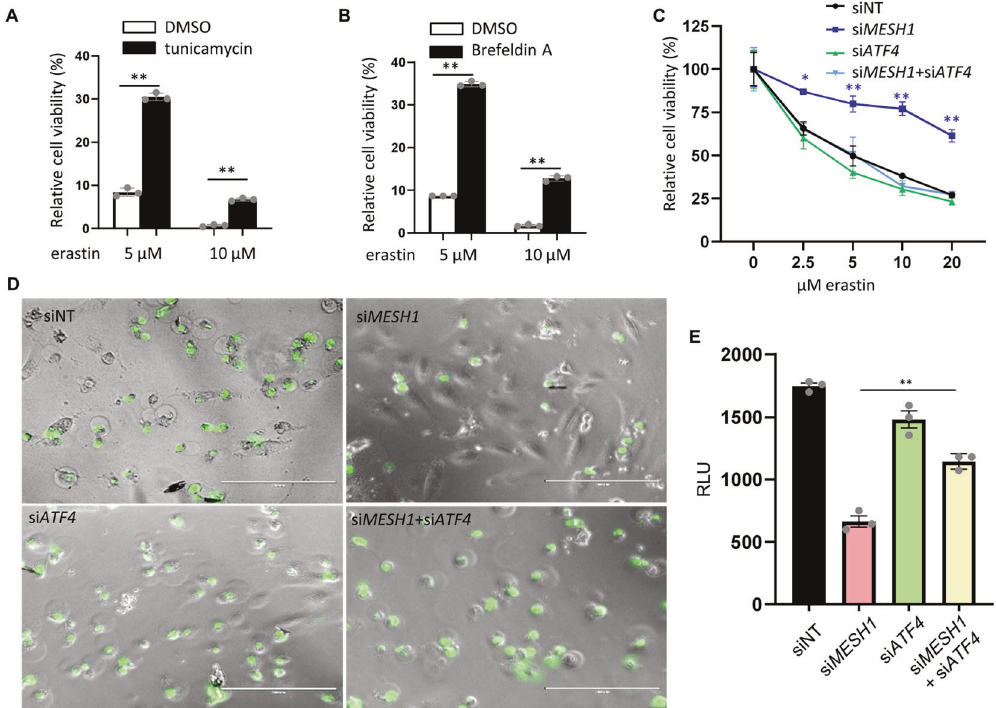
Fig. 4 ISR induced by MESH1 knockdown attenuates ferroptosis. A , B Tunicamycin and brefeldin A treatment prevents erastin-induced cell death. RCC4 cells were treated with erastin and in combination with tunicamycin (6 µg/ml) ( A ) or brefeldin (2 µg/ml) ( B ). The relative cell viability was determined by CellTiter Glo assay. C , D ATF4 -knockdown abolished the ferroptosis survival phenotype of MESH1 -knockdown in RCC4 cells as determined by CellTiter Glo assay ( C ) or CellTox Green assay to observe the membrane rupture under erastin treatment (5 µM) ( D ) and quanti fi ed in ( E ). Statistical analysis: ANOVA with Tukey HSD post hoc test, * P < 0.05, ** P <